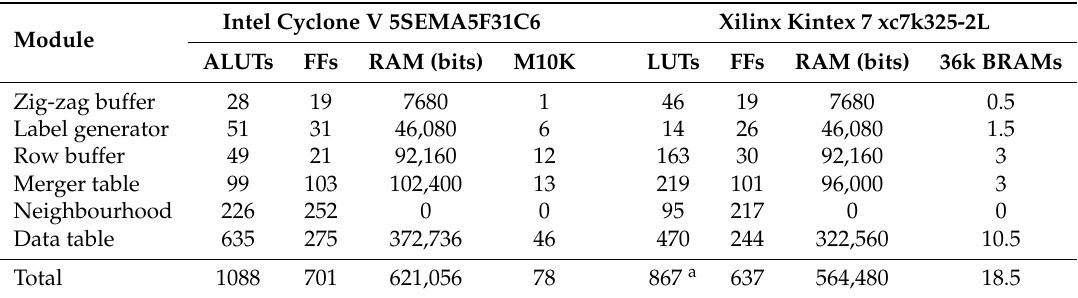
Table 3. Synthesis results targeting a UHD8k image (7680 × 4320). ALUTs are Intel’s adaptive lookup tables; FFs are the number of flip-flops or registers; M10K are the number of Intel’s 10kbit RAM blocks; BRAMs are the number of Xilinx’s 36kbit block